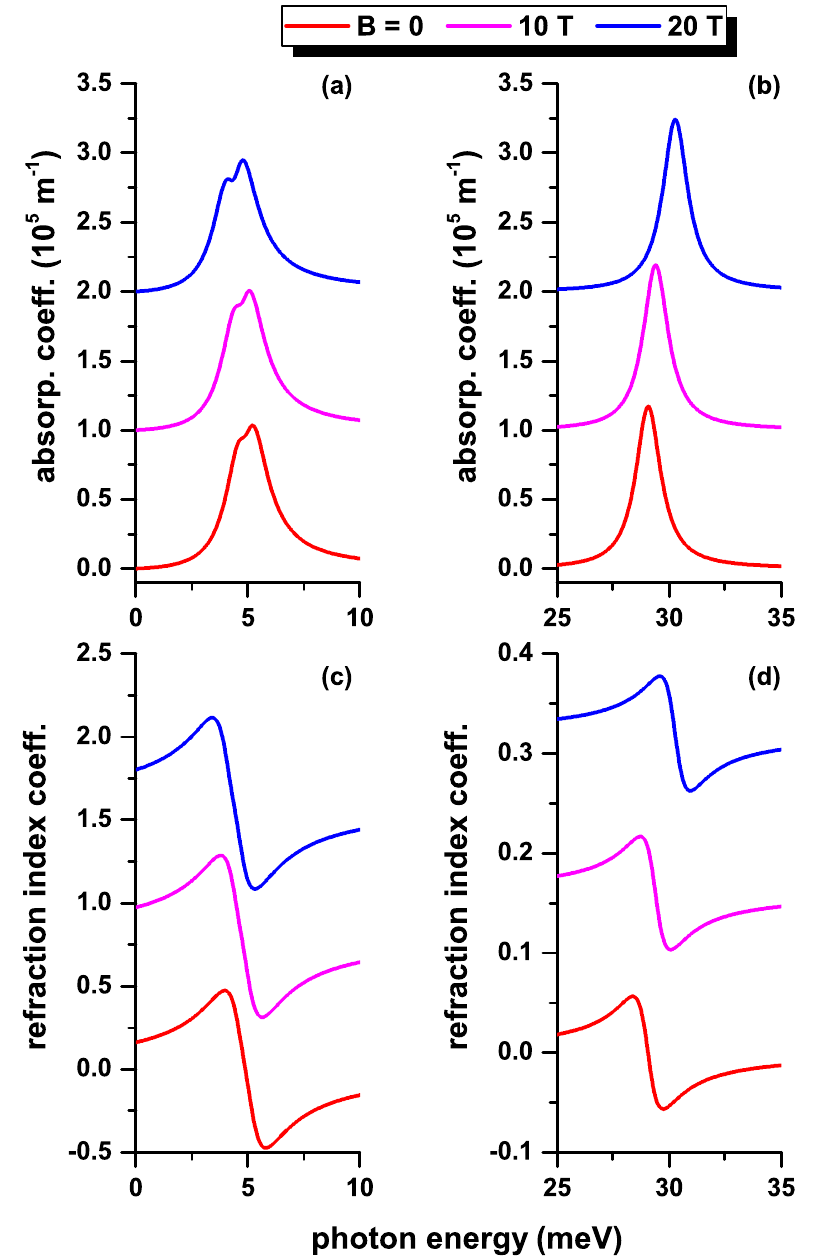
Figure 11. (color online) The total optical absorption coefficient ( a , b ) and the total relative changes of the refraction index coefficient ( c , d ) as functions of the incident photon energy in a CdS/ZnS spherical QD for several values of the MF. Results are without ( a , c ) and with ( b , d ) on-center donor impurity, with R 1 = 20nm and R 2 = 30nm. Optical transitions are between the lowest confined l = 0 states without EF